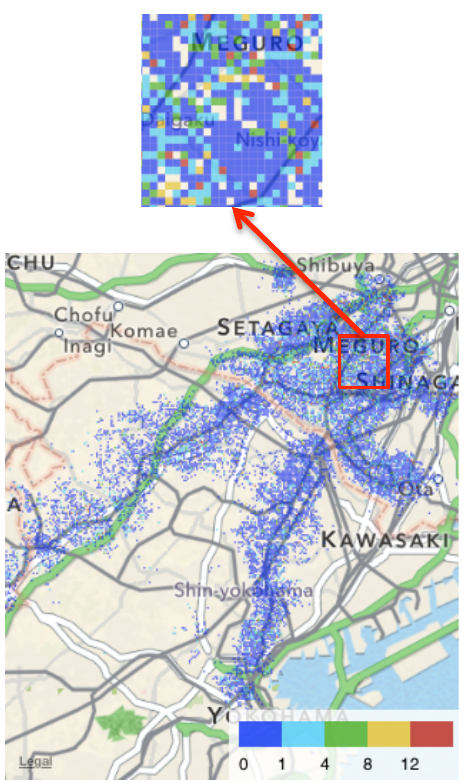
Figure 3. Grids value for the attribute “whether keeping pet is